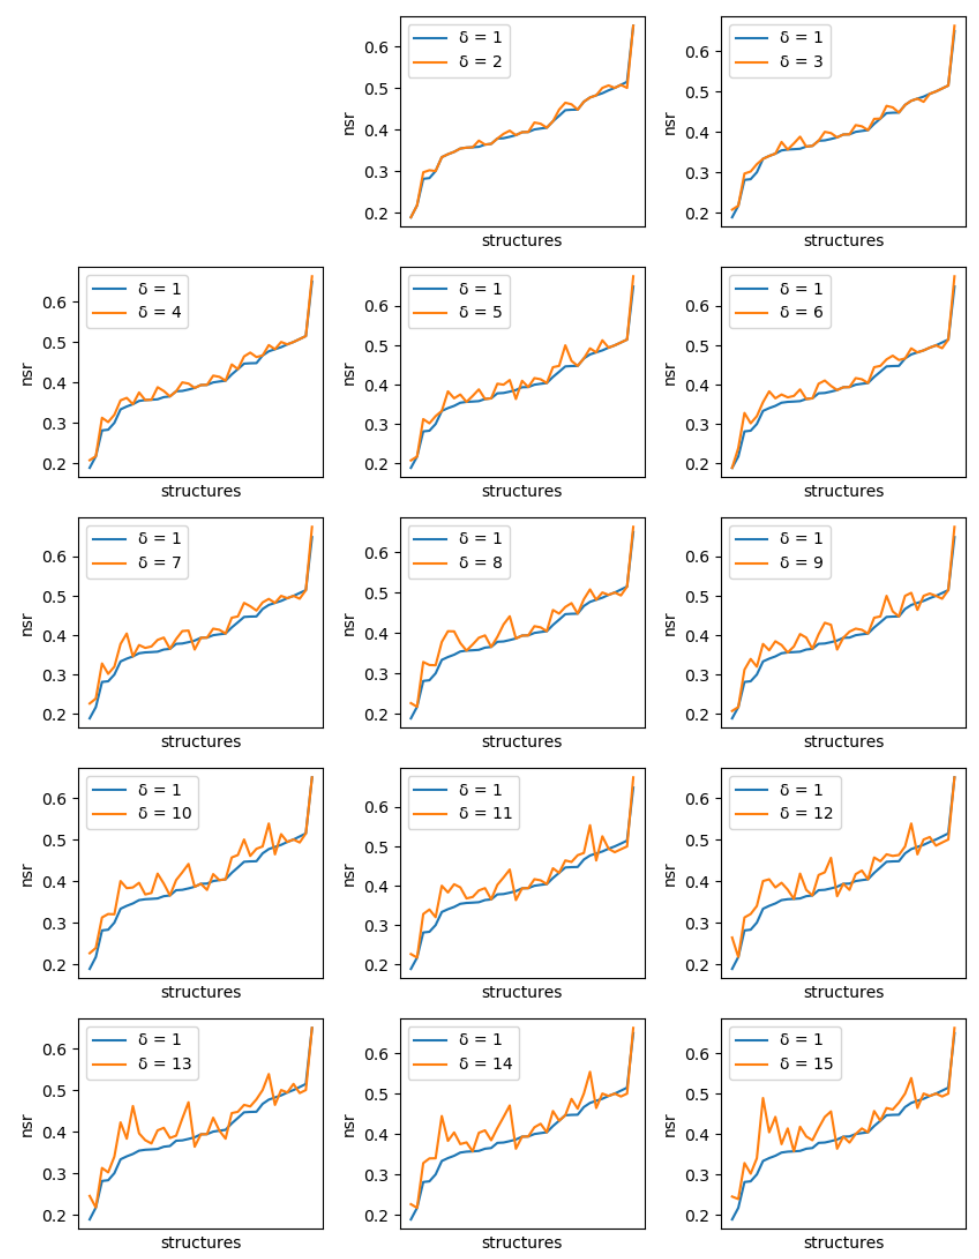
Figure 6. Comparison of the best NSR value obtained with ten 1-diverse sequences ( δ = 1, blue curve) with the best NSR value obtained with libraries of ten sequences of increased diversity. Each plot corresponds to a specific additional value of δ ( δ = 2 to 15, golden curve). Plots are ordered lexicographically from top-left to bottom-right, with increasing values of diversity ( δ ). In each plot, the X-axis ranges over all tested backbones, sorted in increasing order of NSR value for the 1-diverse case and the Y-axis gives the corresponding NSR value. As the diversity requirement increases, the NSR value indicated by the golden curve increases also